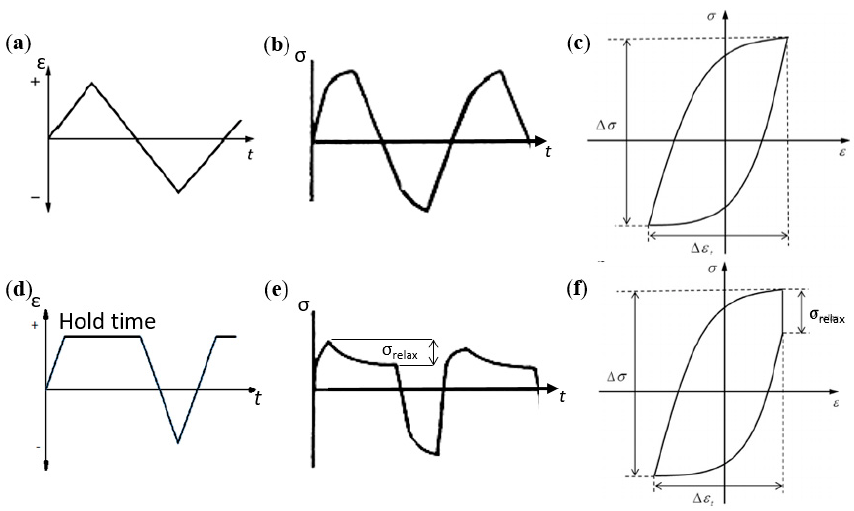
Figure 3. Schematic diagram of typical loading waveform for pure low-cycle fatigue test: ( a ) Strain–time; ( b ) Stress–time; ( c ) Stress–strain curves; and creep-fatigue test with tension hold time: ( d ) Strain–time; ( e ) Stress–time; ( f ) Stress–strain curves.